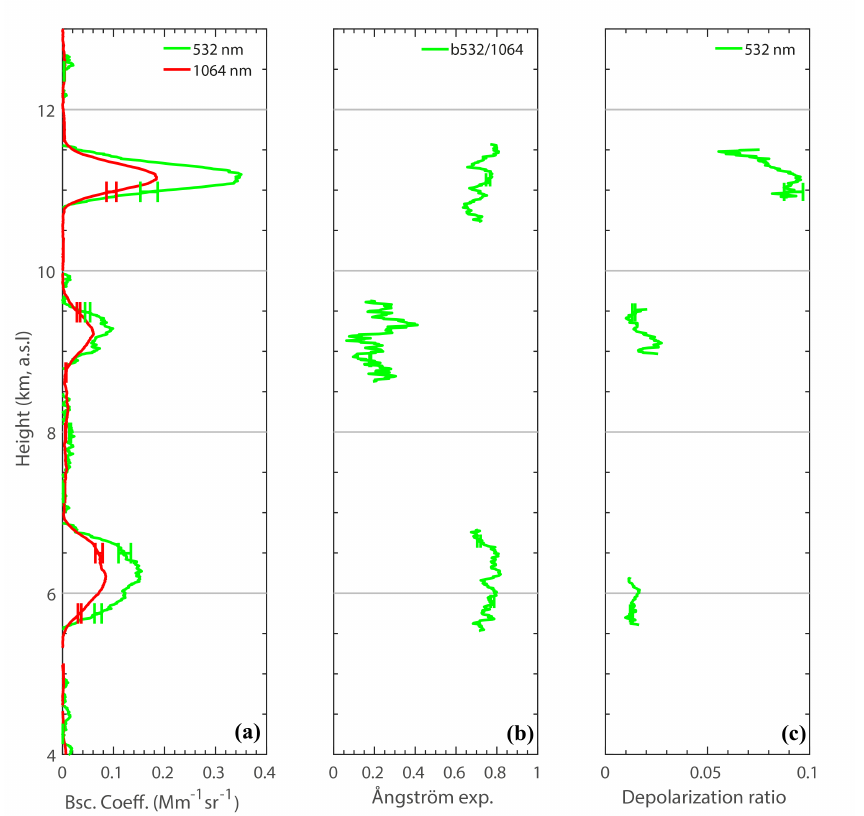
Figure 9. Mean profiles of ( a ) particle backscatter coefficients (at 532 and 1064 nm), ( b ) the correspond- ing backscatter-related Ångström exponents (for 532/1064 nm) and ( c ) particle linear depolarization ratios at 532 nm measured at Punta Arenas on 11 March 2019, 02:45–03:40 UTC. Error bars depict the estimated